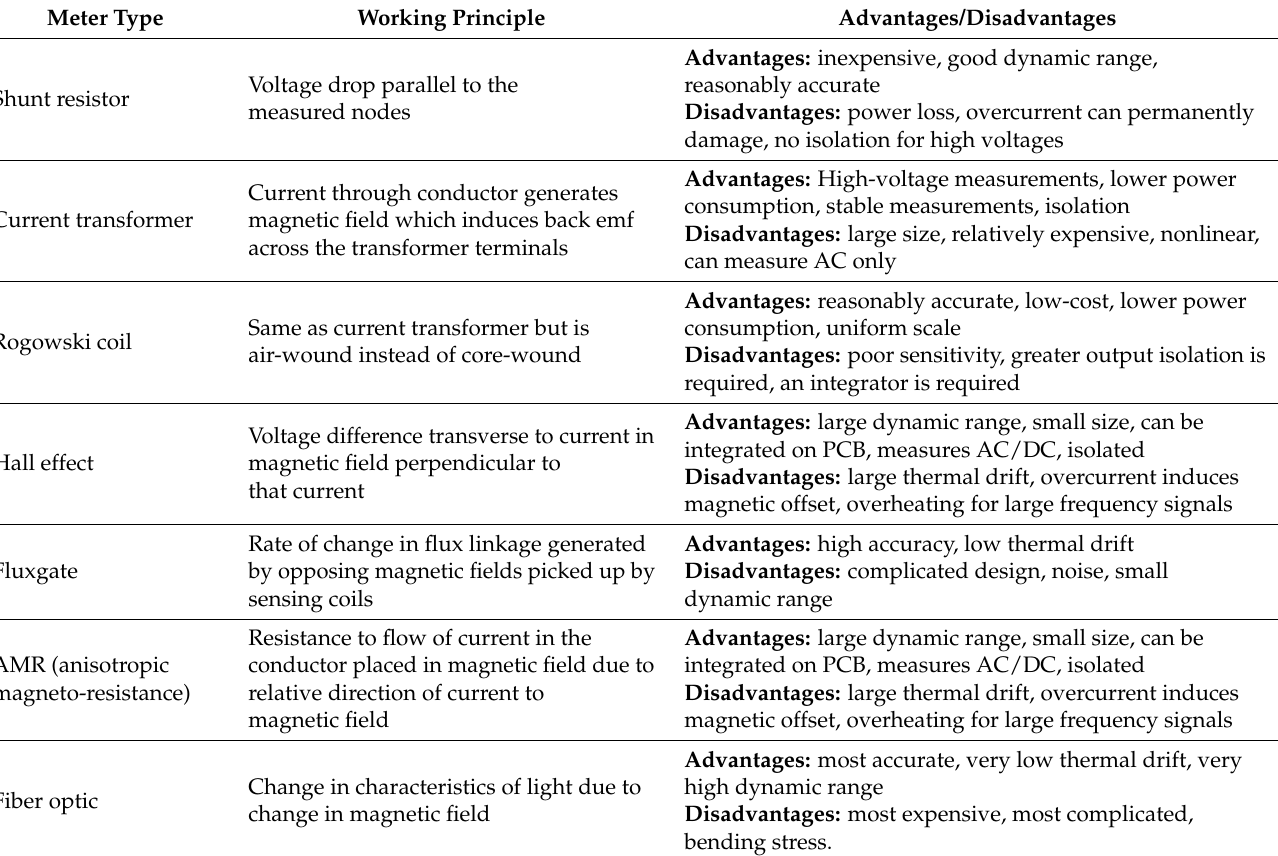
Table 5. Current sensing techniques